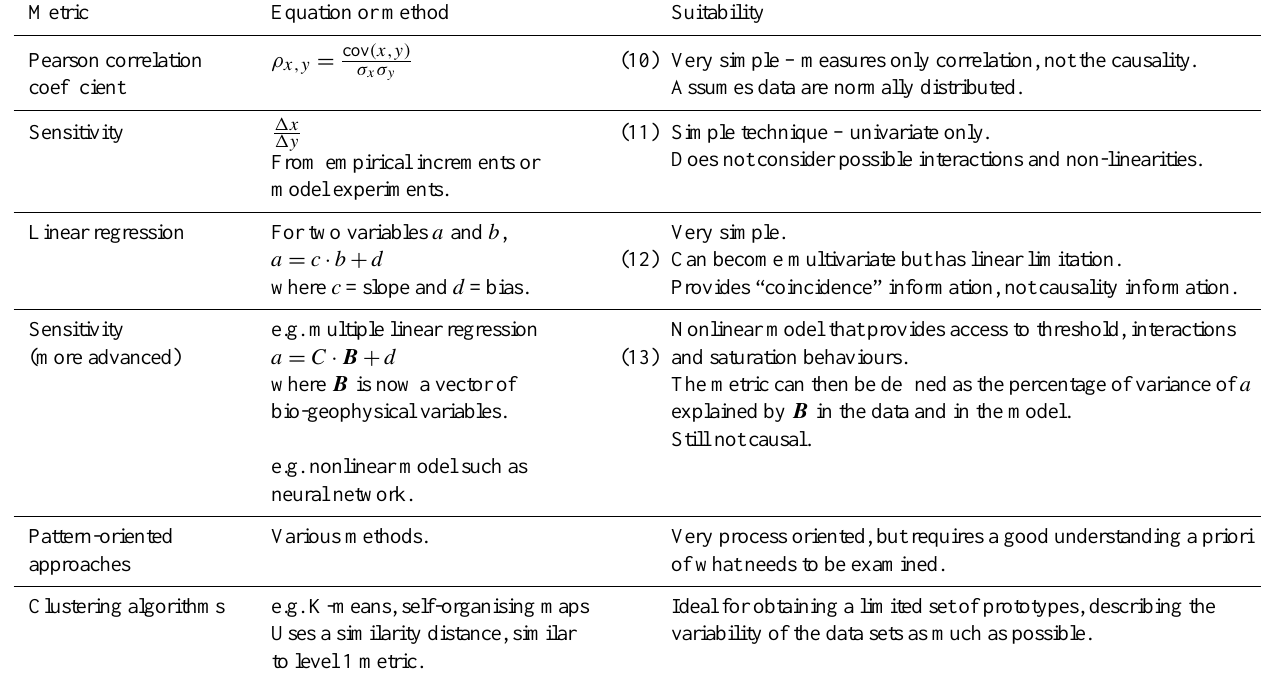
Table 4. Summary of Level 3